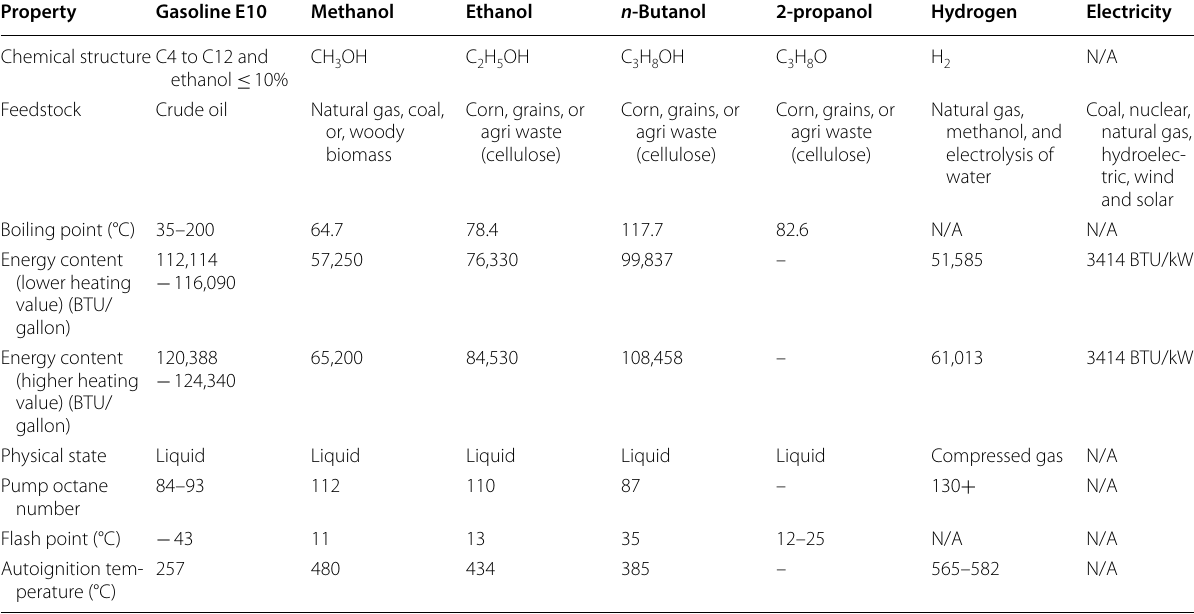
Table 1 Comparison of fuel properties of different fuels [Refs. (Kiss et al. 2016; Balat 2011; Prakash et al. 2016)] Property